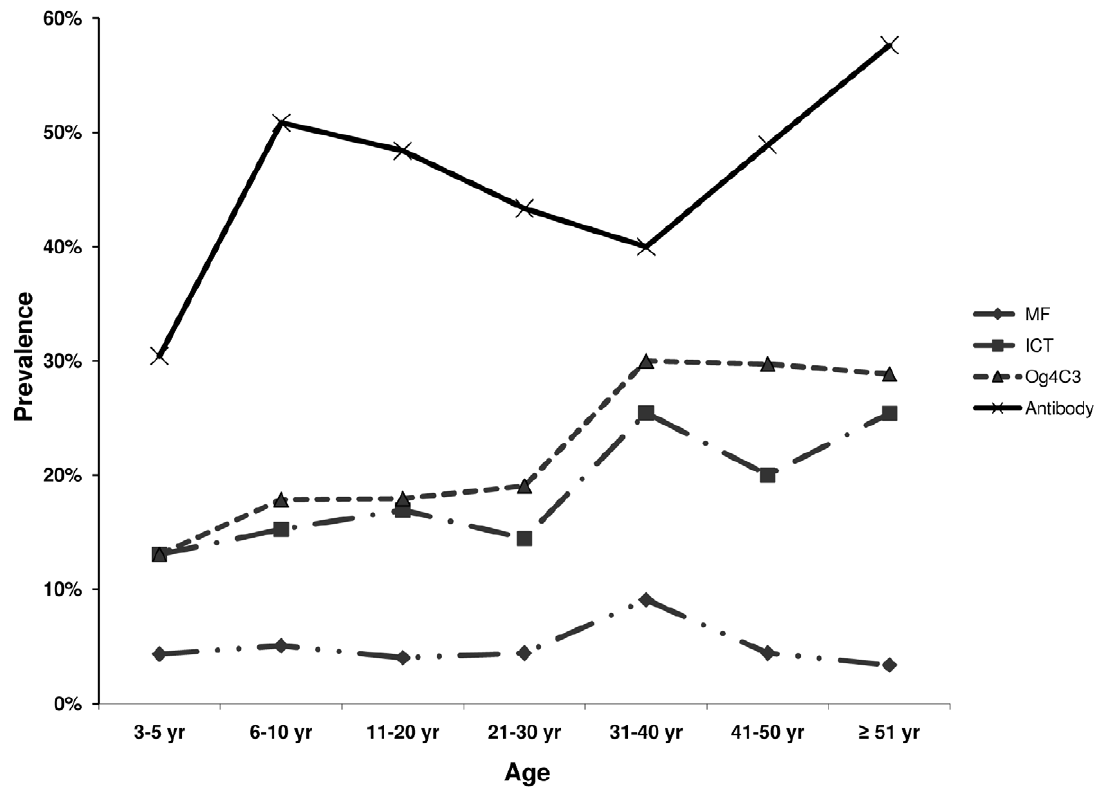
Figure 1. Age prevalence curves based on the various infection measures. Data are summarized across all communities. MF=microfilaremia ICT=filarial antigen detected by ICT card test. Og4C3 = ELISA assay to detect filarial antigen Bm14= filarial antibody ELISA.